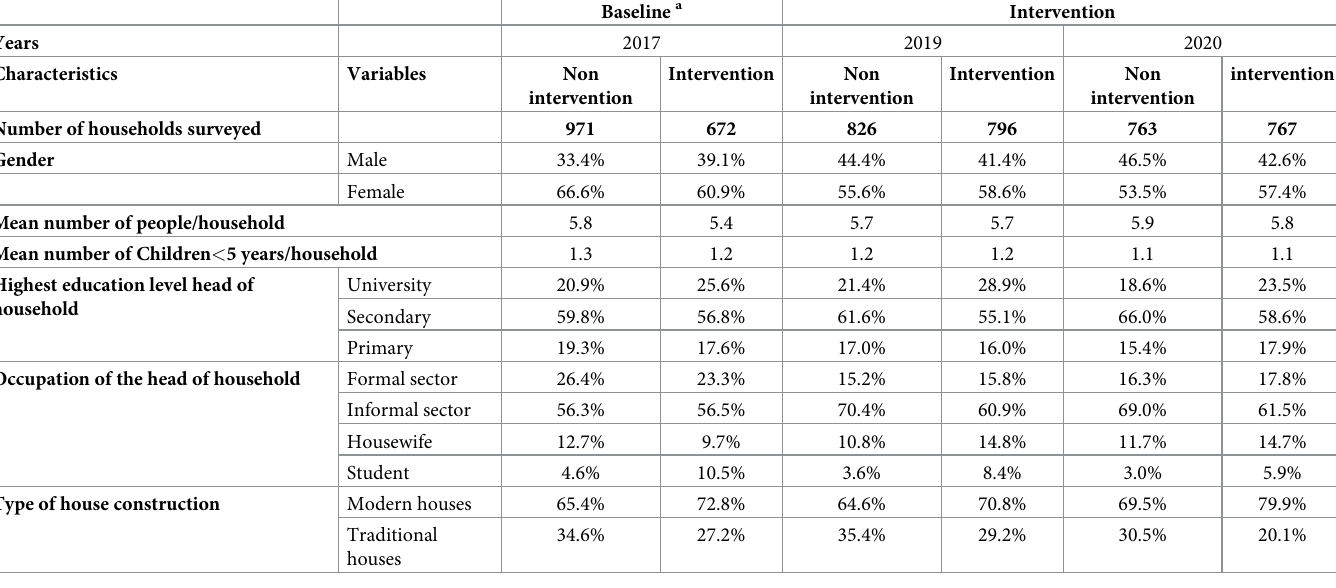
Table 2. Characteristics of households surveyed stratified by larviciding phase and intervention